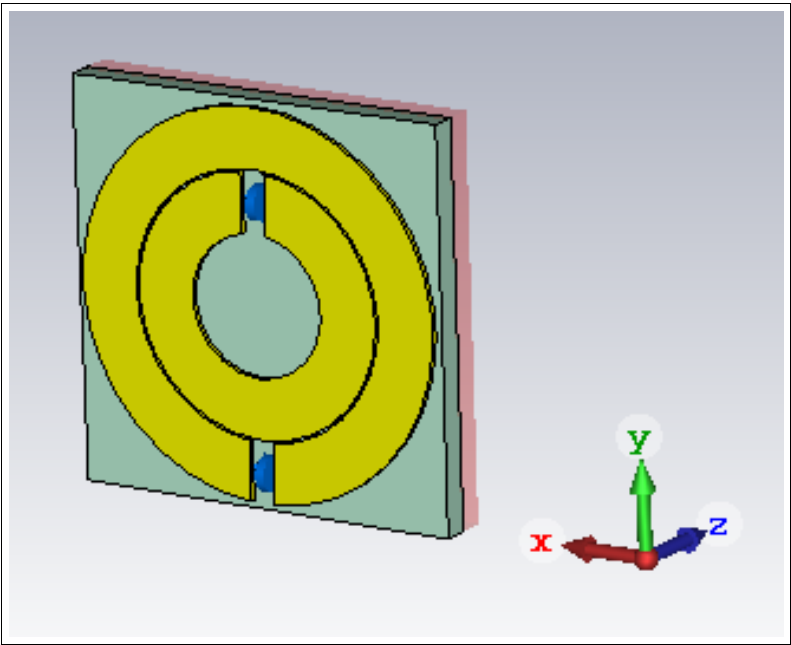
Figure 6. DNG unit cell